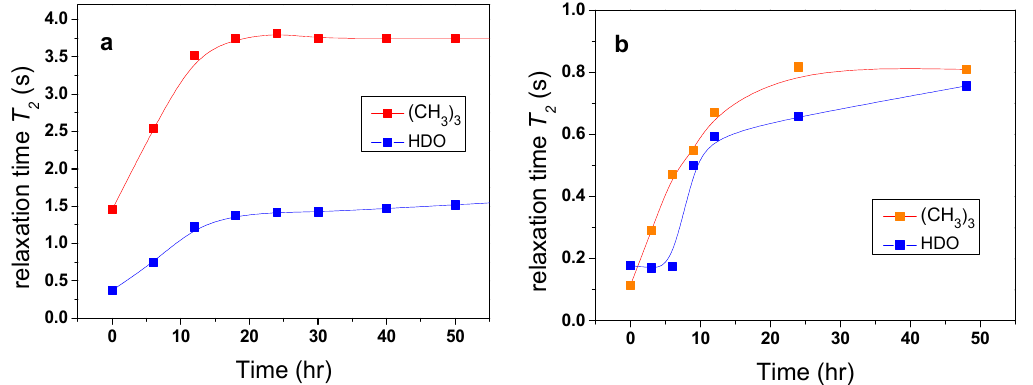
Figure 6. Time dependences of the spin-spin relaxation time T 2 of HDO and (CH 3 ) 3 protons of additive in PVME/TBOH ( a ) and PVME/TBMK ( b ) solutions ( c P = 5 wt %, c ad = 5 wt % in D 2 O) measured above the phase transition.